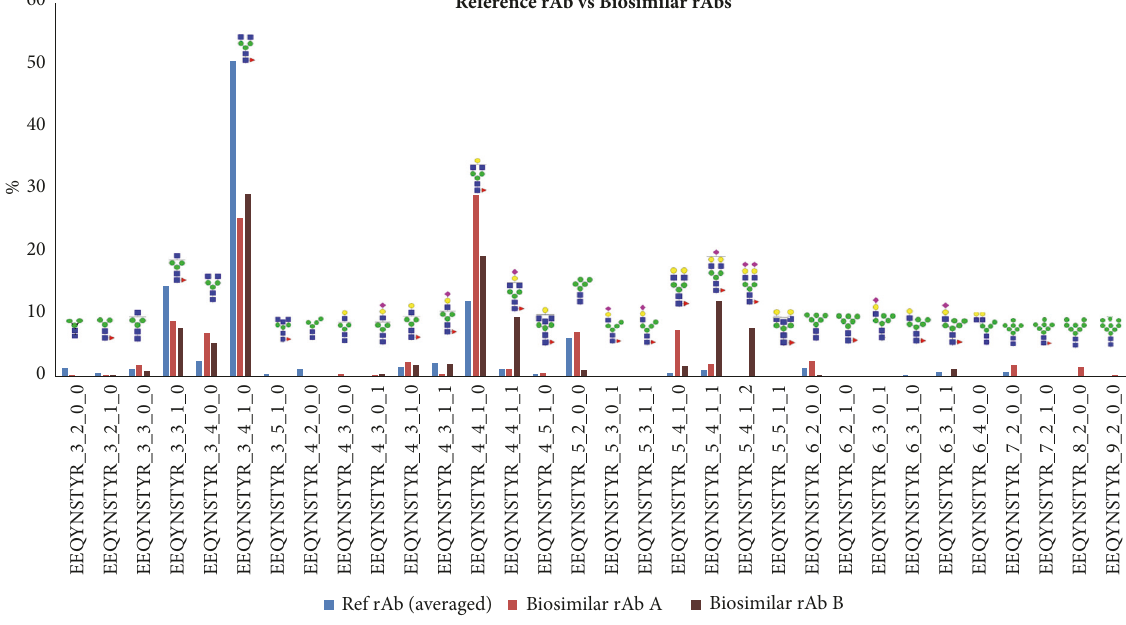
Figure 4: Comparison of glycosylation patterns of the reference rAb and the biosimilar rAb samples, obtained by LC-ESI-MS/MS. The glycosylation patterns for the reference rAb sample were obtained by triplicate analysis and averaged. All datasets acquired from each glycoprotein sample were normalized before comparative